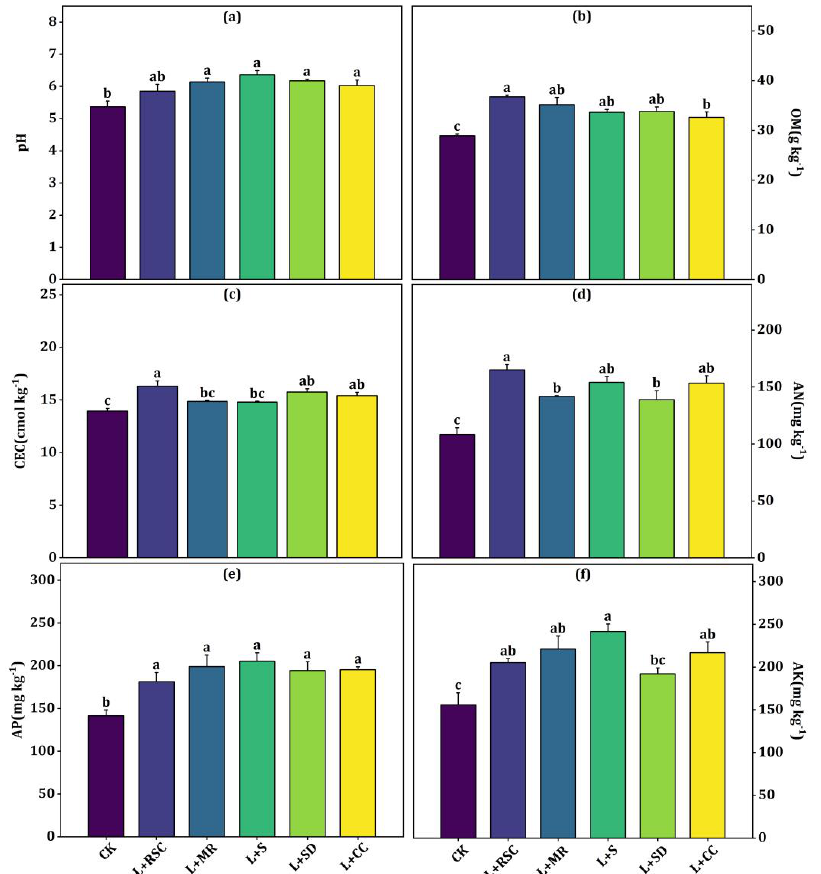
Figure 1. Effect of LOM on soil pH ( a ), OM ( b ), CEC ( c ), AN ( d ), AP ( e ), and AK ( f ) of A. selengensis . All values are means of three replicates with error bars indicating the standard error. Different lowercase letters show significant variability among treatments ( p < 0.05).